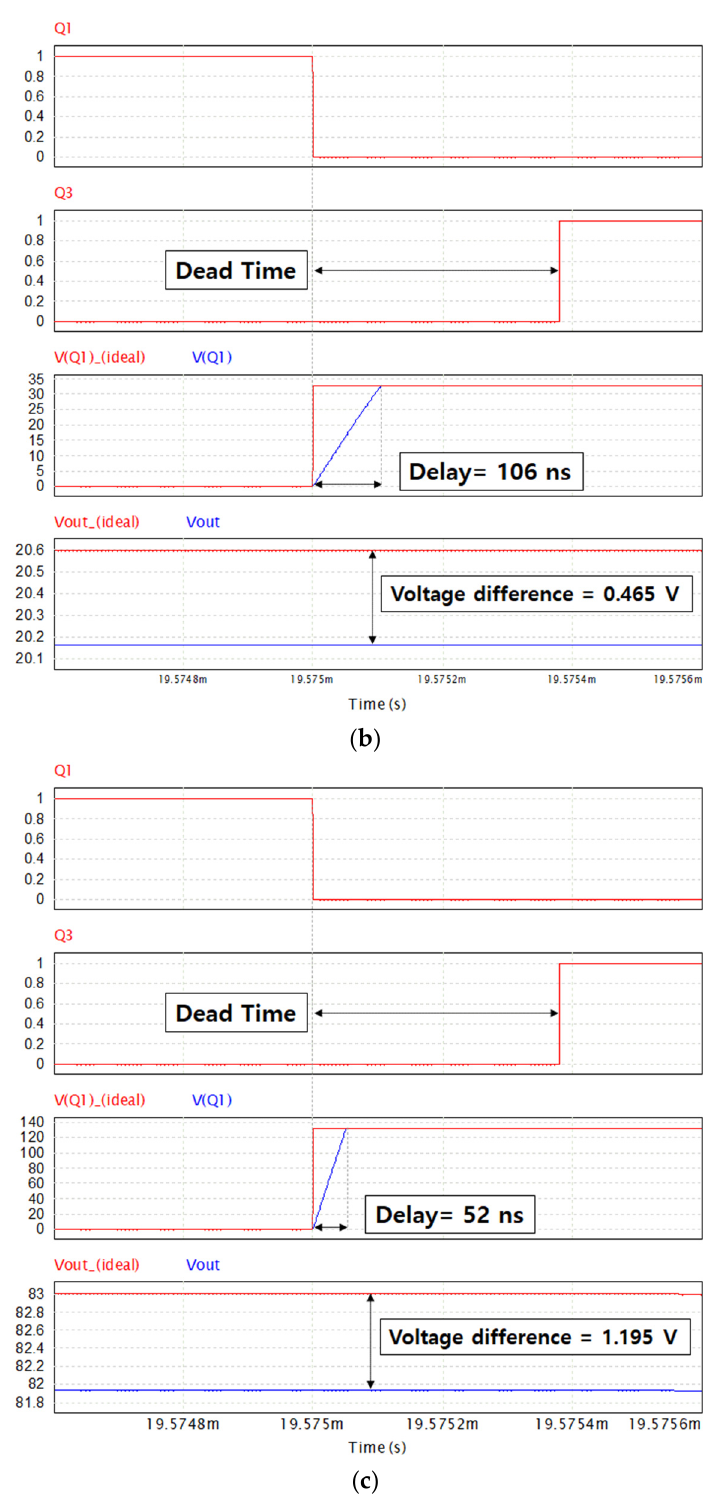
Figure 8. Simulation waveform and result: ( a ) input voltage 13 V; ( b ) input voltage 33 V; ( c ) input voltage 133 V.